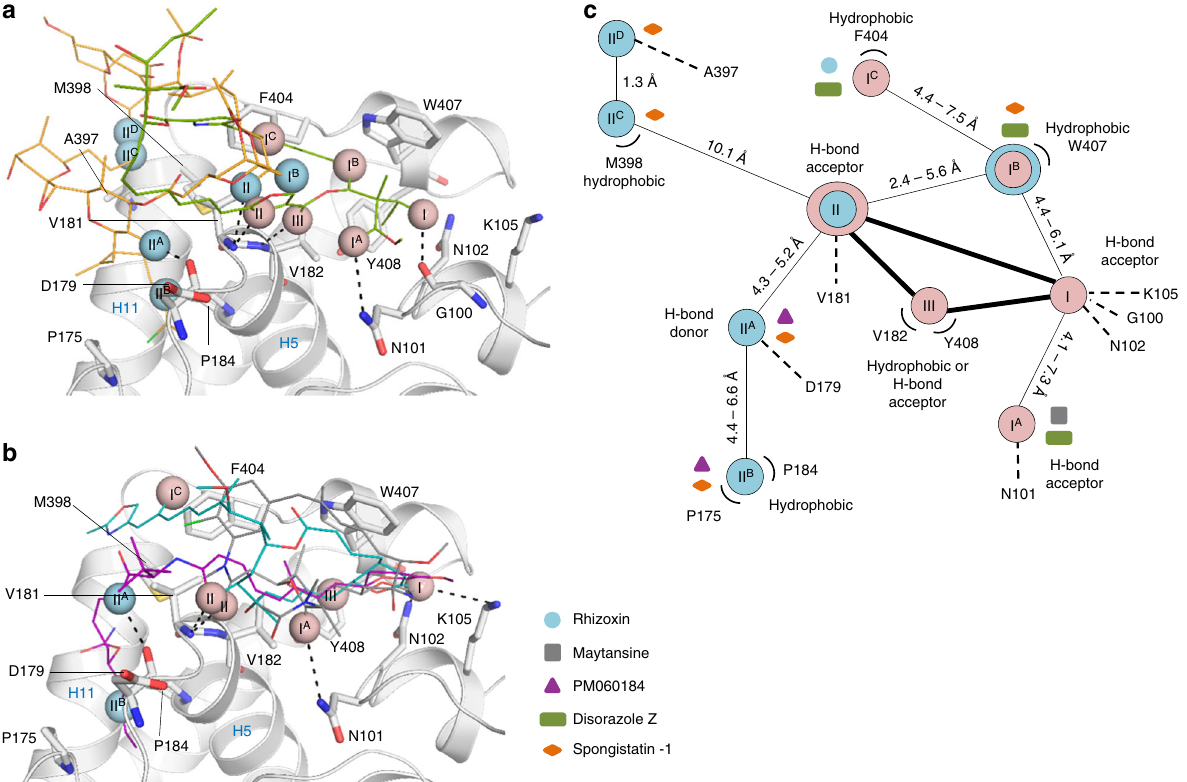
Fig. 5 Maytansine-site pharmacophore. a Superposition of tubulin-bound spongistatin-1 (orange) and disorazole Z (green) ( b ) Superposition of tubulin- bound maytansine (gray), rhizoxin F (cyan) and PM060184 (purple). The main interacting residues are labeled in black and hydrogen bonds are represented by black broken lines. Secondary structure elements are labeled in blue. The interacting parts of the molecules are depicted with spheres and labeled according to c . c Schematic drawing of the maytansine-site pharmacophore with additionally explored regions. The secondary interaction points are labeled I A , I B and I C and II A , II B , II C and II D . Differently colored symbols are assigned to each of the fi ve maytansine-site ligands, which appear close to the corresponding interacting